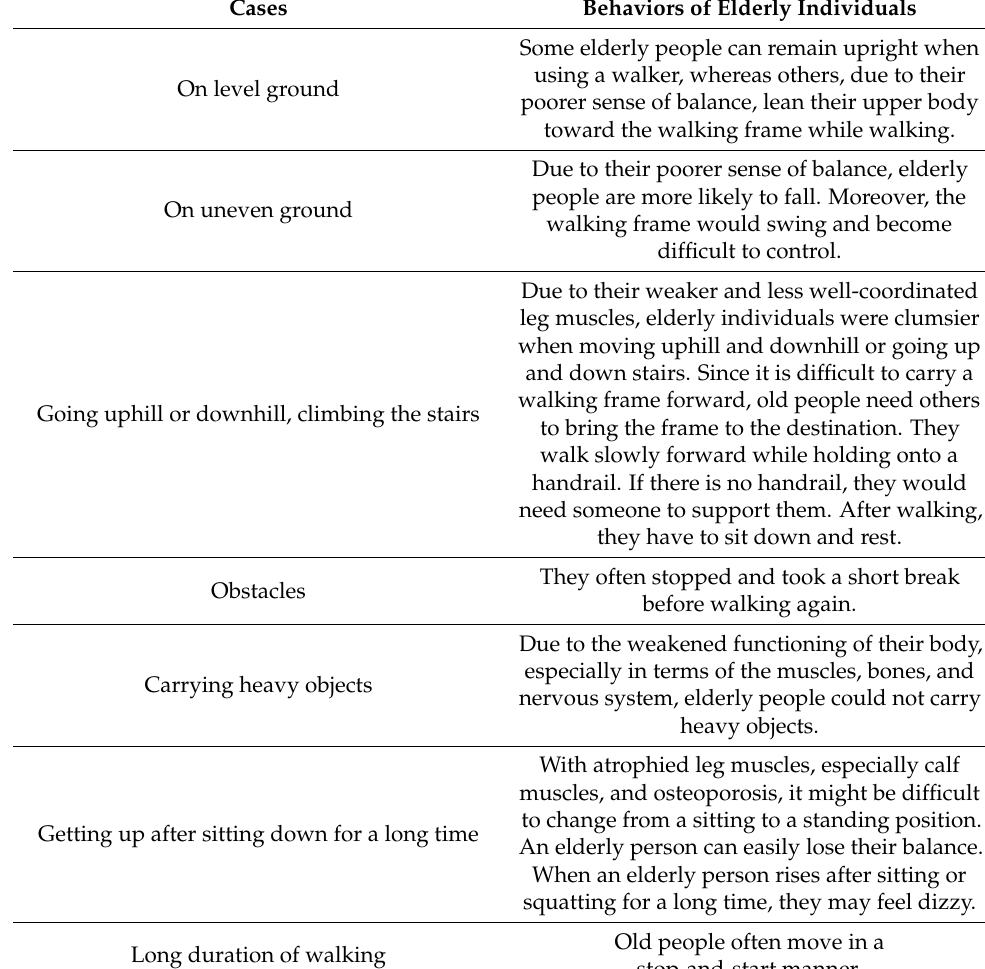
Table 4. Characteristics of the elderly with walking aids in different pedestrian